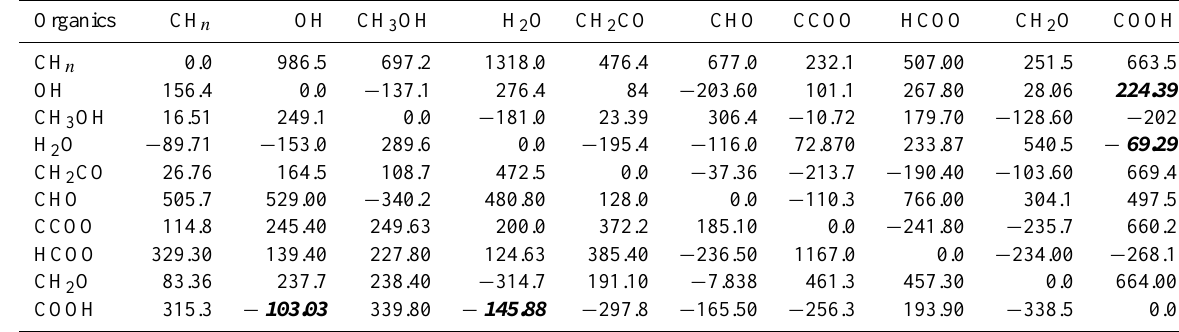
Table A4. UNIFAC interaction parameter (E-AIM). Values from Peng et al. (2001) are presented in bold italic . Organics